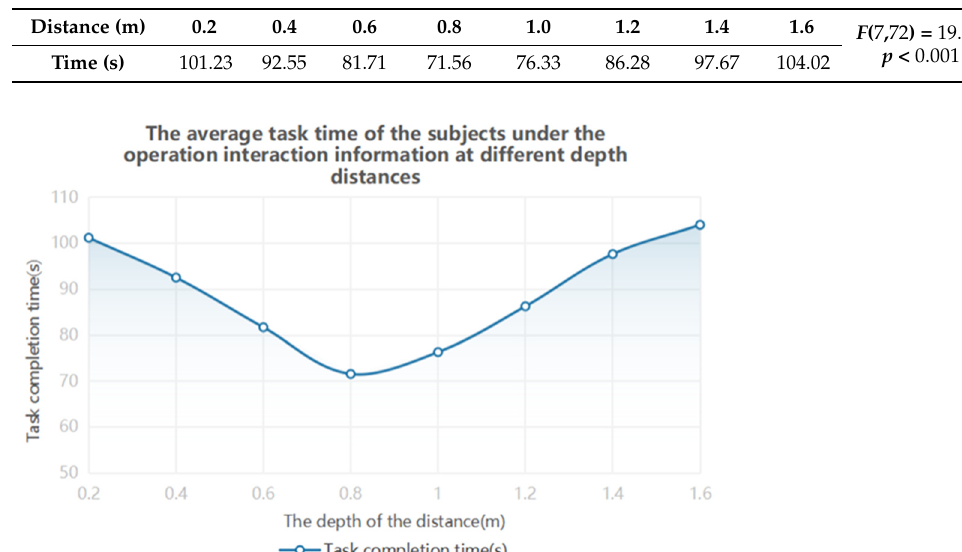
Figure 6. Time variation trend of operation interaction information to complete tasks at different depths and distances.